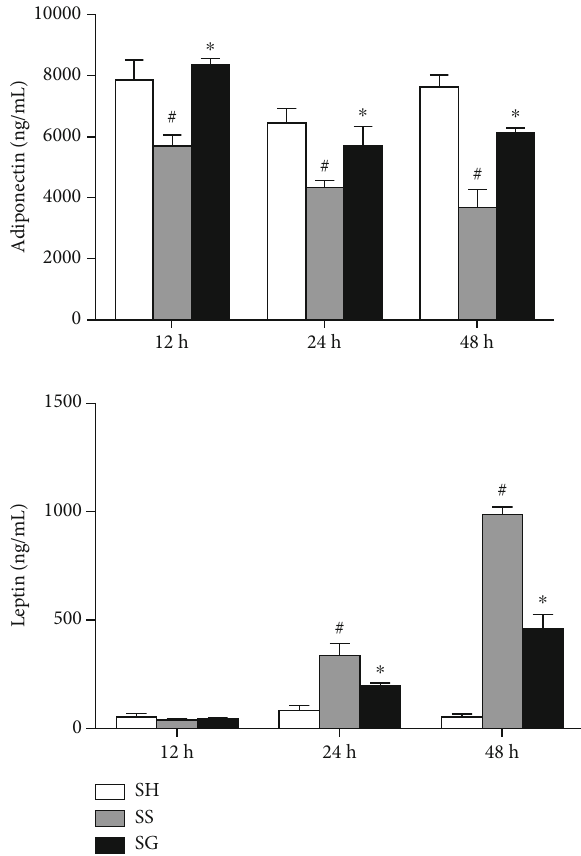
Figure 1: Plasma adiponectin and leptin concentrations in the obese sham-operated and sepsis groups at di ff erent time points. SH: sham-operated group; SS: sepsis group with saline; SG: sepsis group with glutamine. Values are expressed as the mean ± SEM